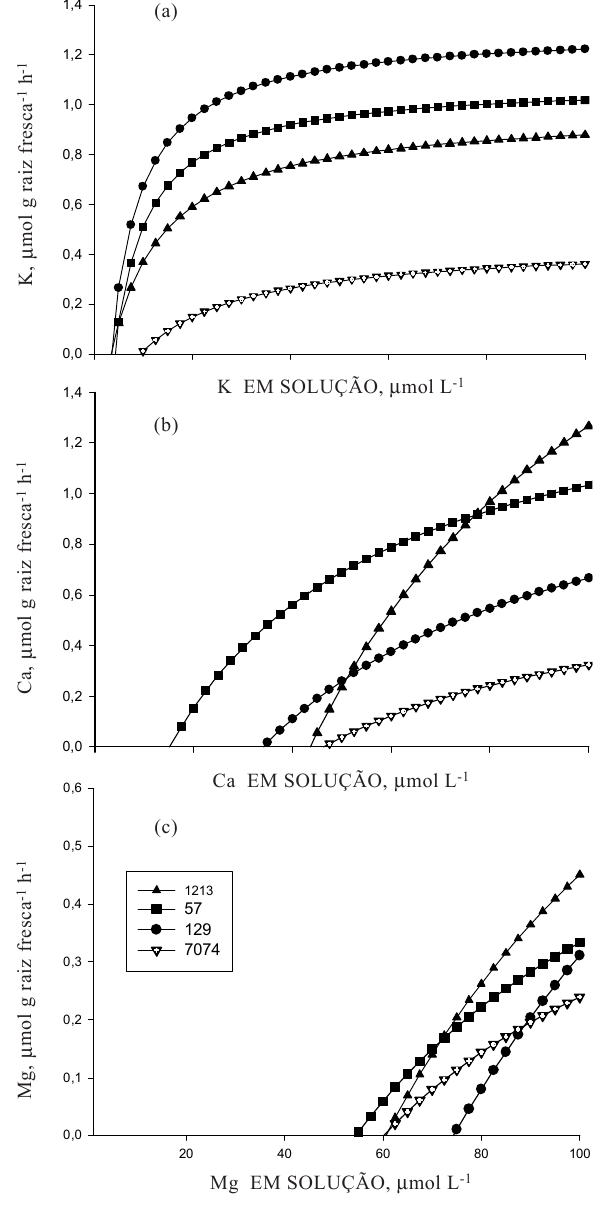
Figura 1. Influxos estimados de K (a), de Ca (b) e de Mg (c) em mudas de clones de eucalipto, considerando de suas respectivas concentrações em solução. O clone 1213 foi obtido de híbrido de E. grandis x E. urophylla , enquanto os demais foram de híbridos de E.grandis